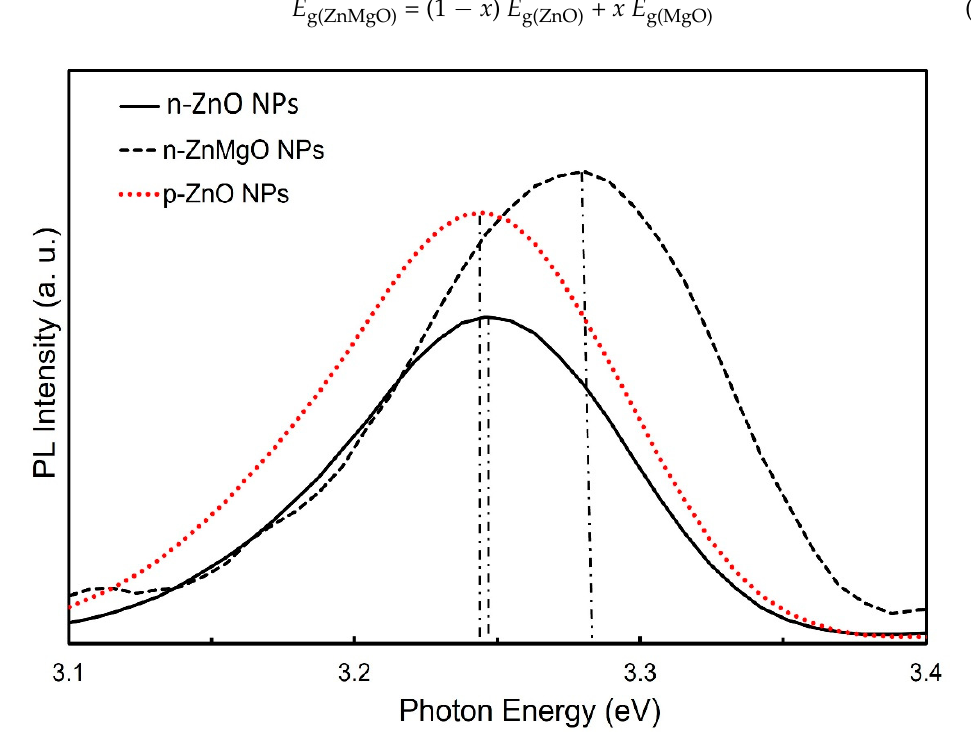
Figure 3. Room-temperature photoluminescence spectra of n-ZnO NPs, n-ZnMgO NPs and p-ZnO NPs.